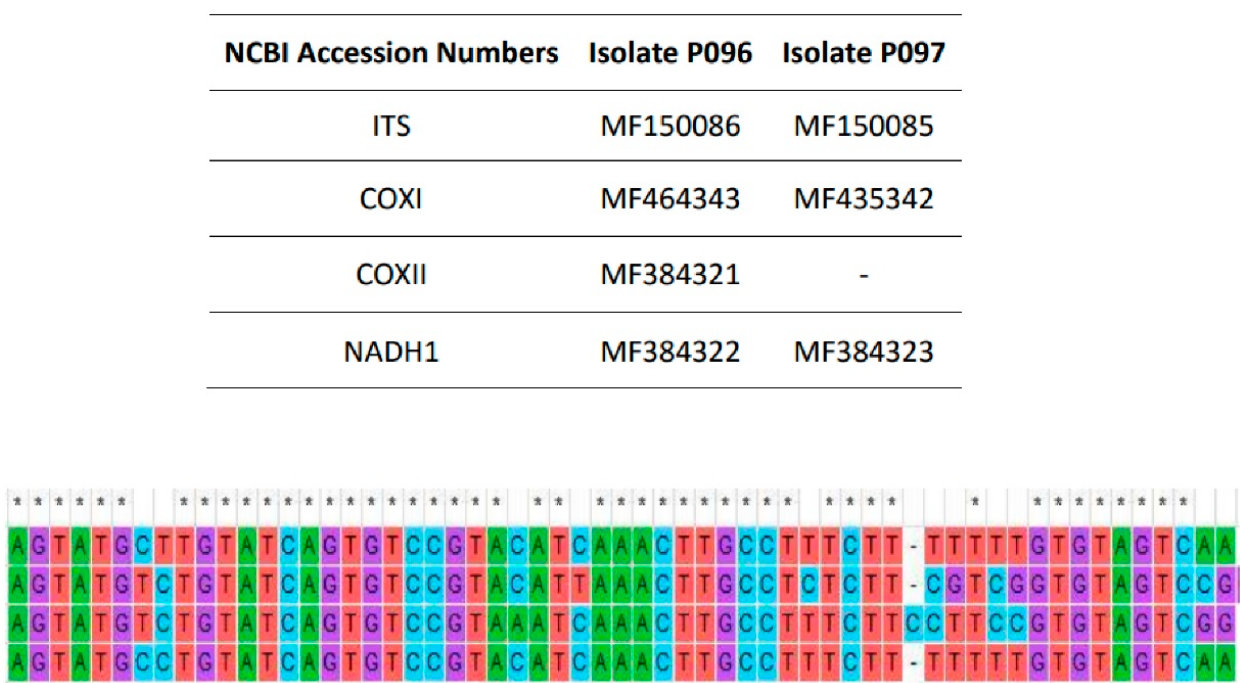
Figure 1. Accession numbers of the sequences of Pythium kashmirense deposited in NCBI (Above); Sequence comparison of the ITS region of Pythium kashmirense (P096), Py. rostratifingens (P216), Py. sylvaticum (P194) and Py. dissotocum (P107), from top to bottom, sequence fragment from 496 to 554 bp (below). * indicates no variation in the nucleotide at that single position.